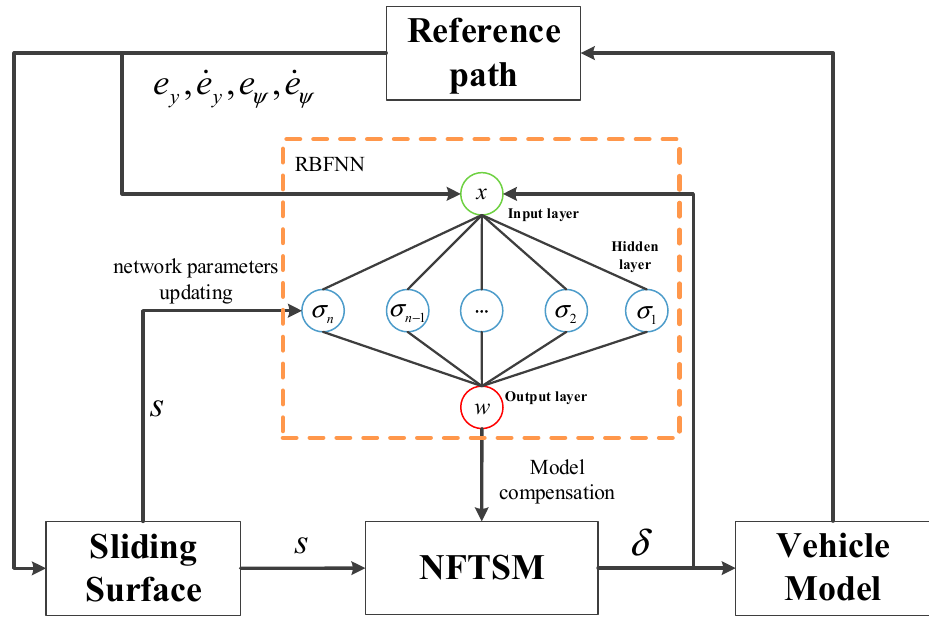
Figure 3. The structure of RBFNN-based NFTSM control algorithm.